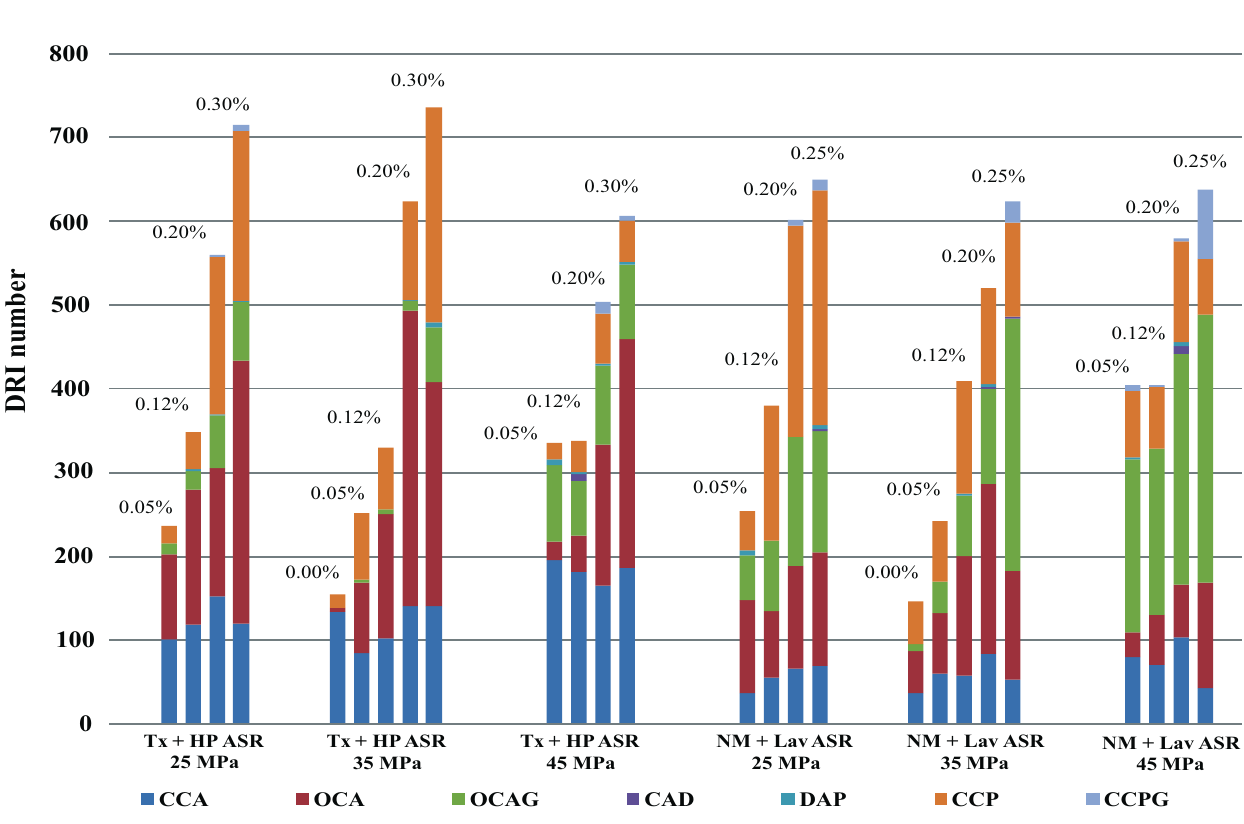
DRI charts for all the mixtures analyzed over the study. The common legend for all graphs is given in Figure